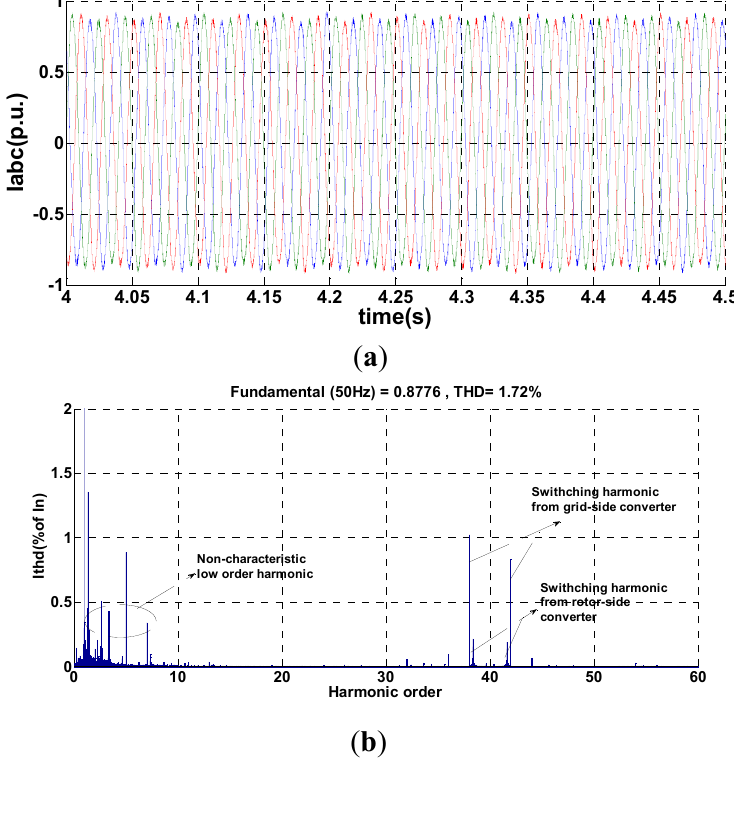
Figure 9. Switching harmonic simulation. ( a ) Currents of the small-scale wind farm without filter; ( b ) I without filter; ( c ) I with filter; ( d ) Comparison of V thd thd